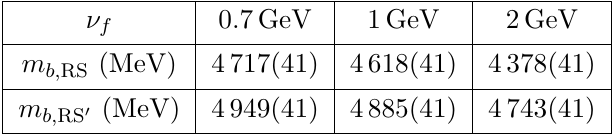
Figure 1 . Plots of M (cid:17) for (cid:23) f = 2 GeV, m b; RS = 4 : 378 (cid:0) 41 b Red line is the experimental value, black dashed line is 2 m dashed and green long-dashed are the LO-NNLO contributions respectively. Solid black line is the N 3 LO, and the dotted black line the N 3 LO without (cid:14)E US error of m associated to the uncertainty of m b . Left panel: plot of M (cid:17) b; RS = RS 0 panel: plot of M (cid:17) in RS’ scheme. b